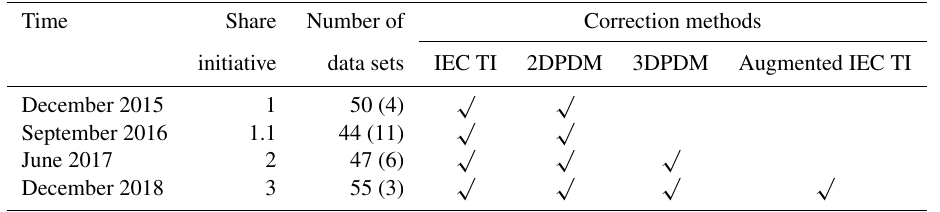
Parentheses indicate the number of remote sensing data sets.